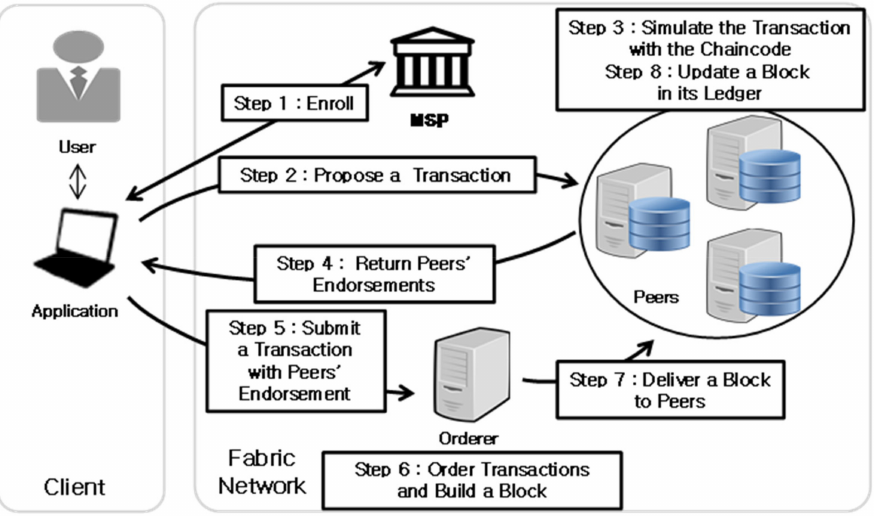
Figure 3. Working steps of creating and updating a block in the HyperLedger Fabric